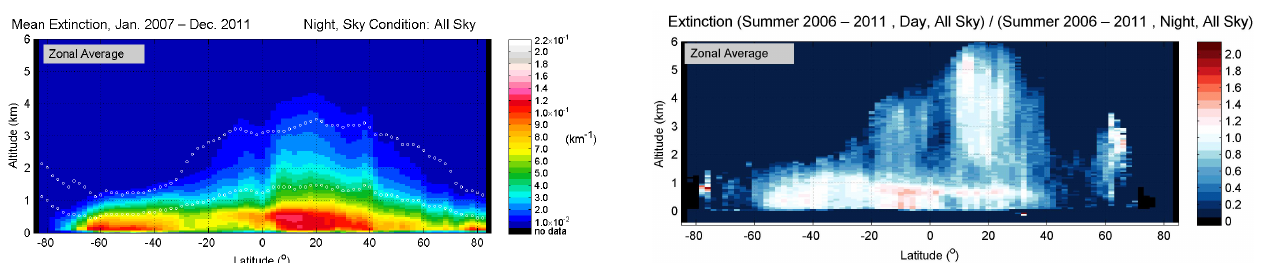
Fig. 6. Zonal mean 532nm aerosol extinction (km − 1 ) , from January 2007 to December 2011, nighttime, all-sky.